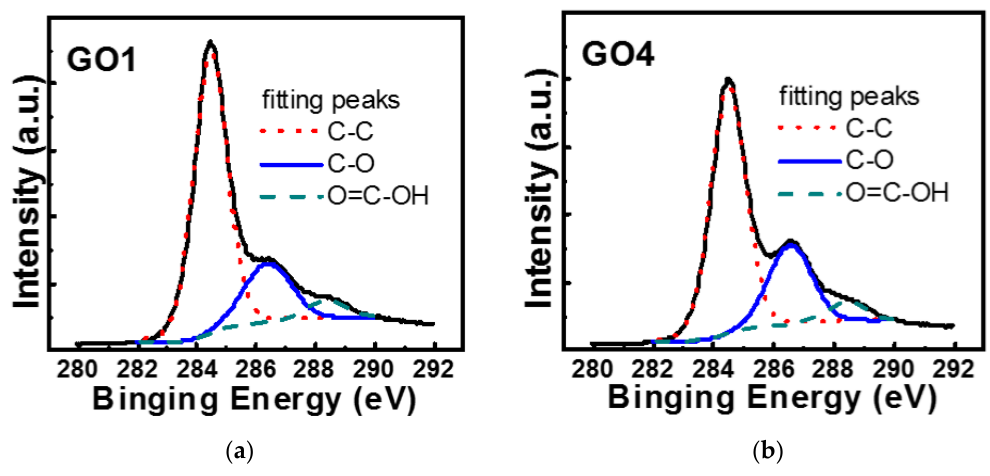
Figure 4. C1s XPS results for ( a ) GO1 and ( b ) GO4. The XPS intensity ratio of C–O (at 286.5 eV) to C–C (at 284.5 eV) bonds of GO4 was larger than that of GO1.